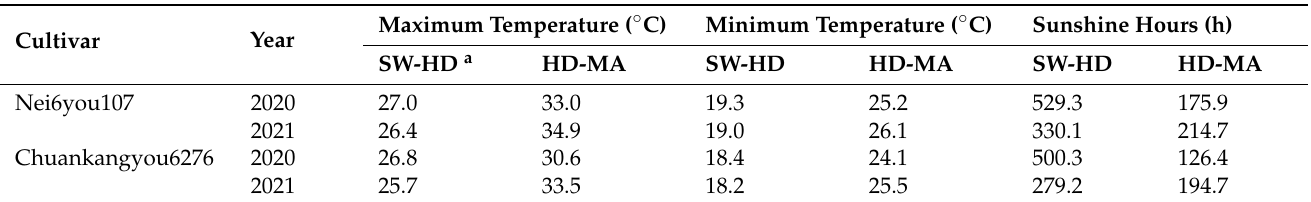
Table 1. Daily maximum and minimum temperatures and sunshine hours during the rice-growing